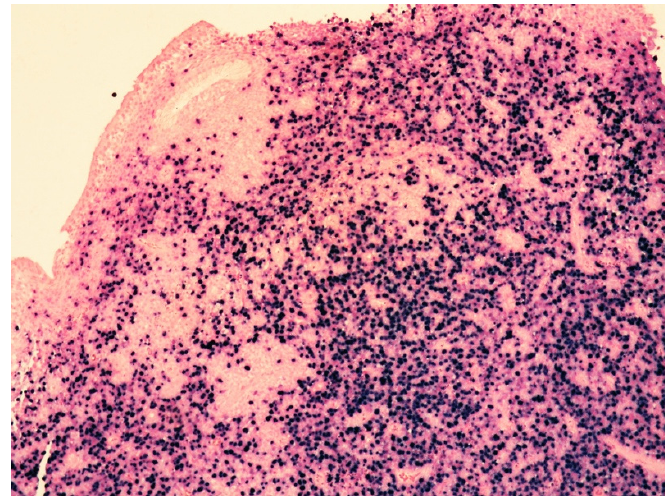
Figure 9. Medium-power view showing a diffuse proliferation of EBER-positive cells (in situ hy- bridization for EBV-encoded RNA, 100× magnification, previously unpublished, original image from S.A.).